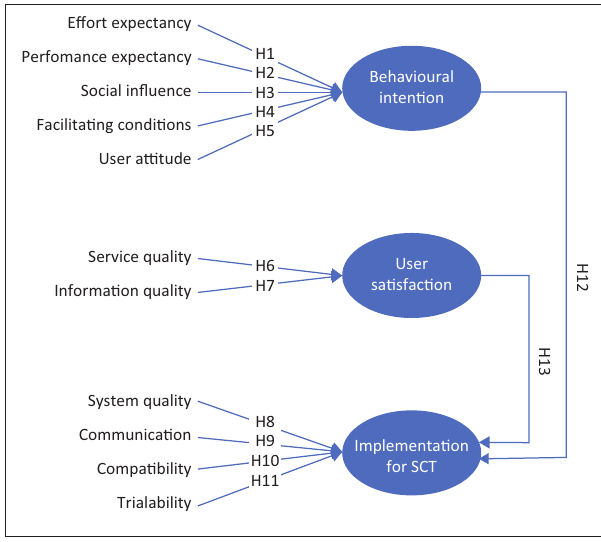
FIGURE 1: Develop a model for critical success factors for the adoption of smart card technology in South African public hospitals.